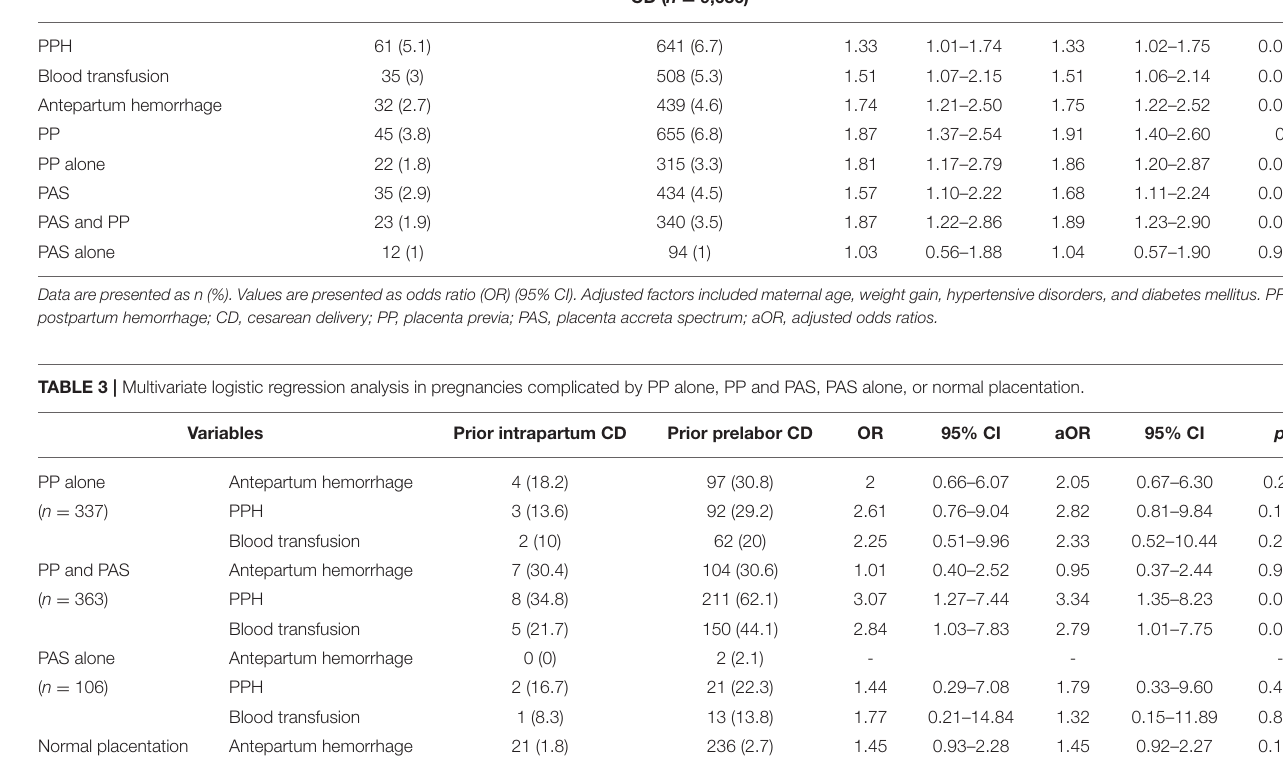
TABLE 2 | Multivariate logistic regression analysis on all the subsequent pregnancies. Variables